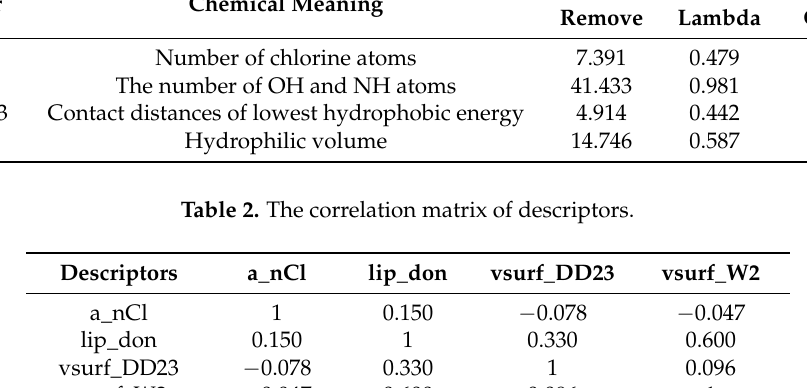
Table 2. The correlation matrix of descriptors.